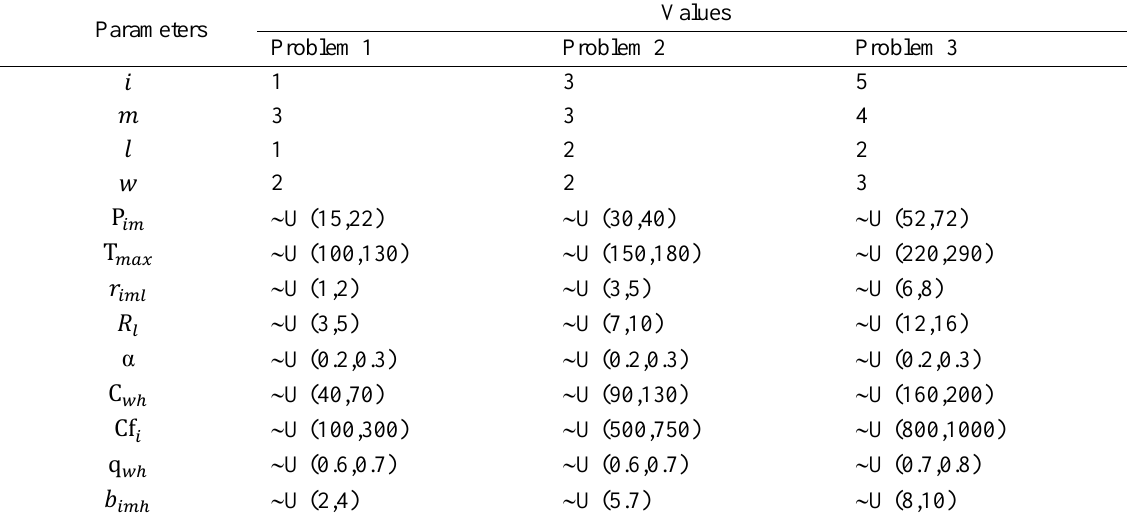
Table 2. Data sets generated